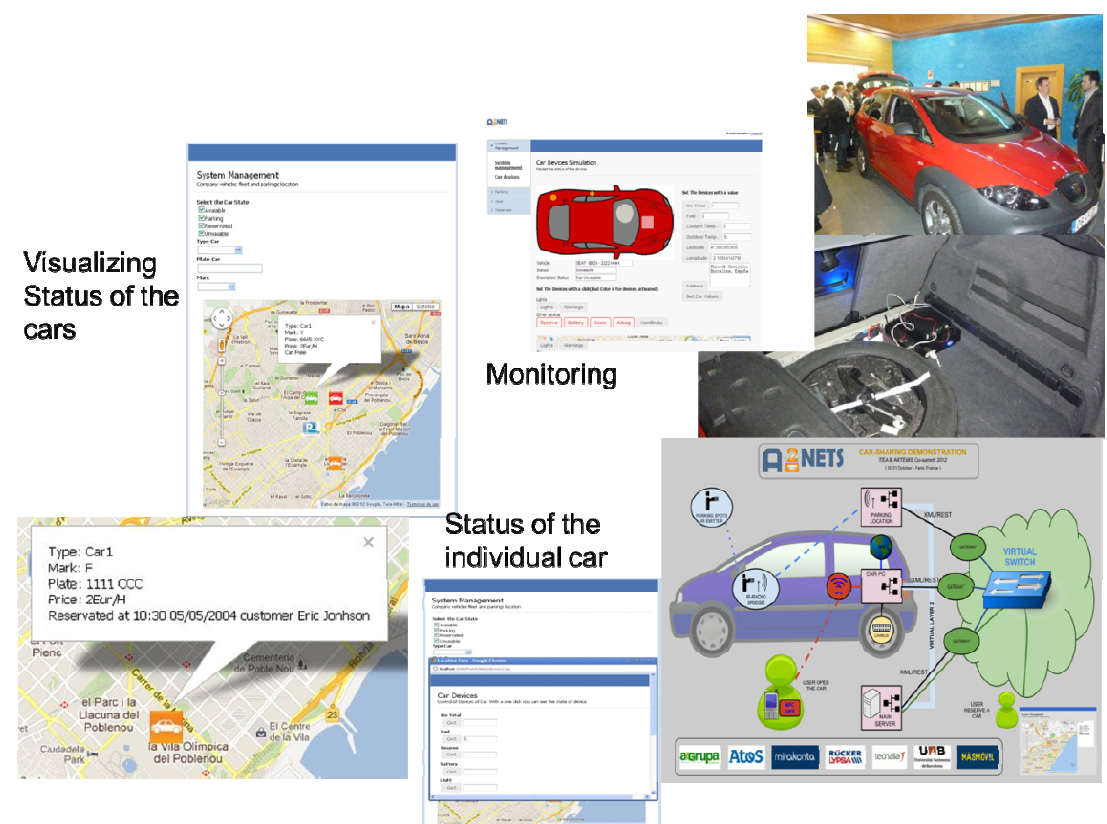
Figure 20. Car sharing